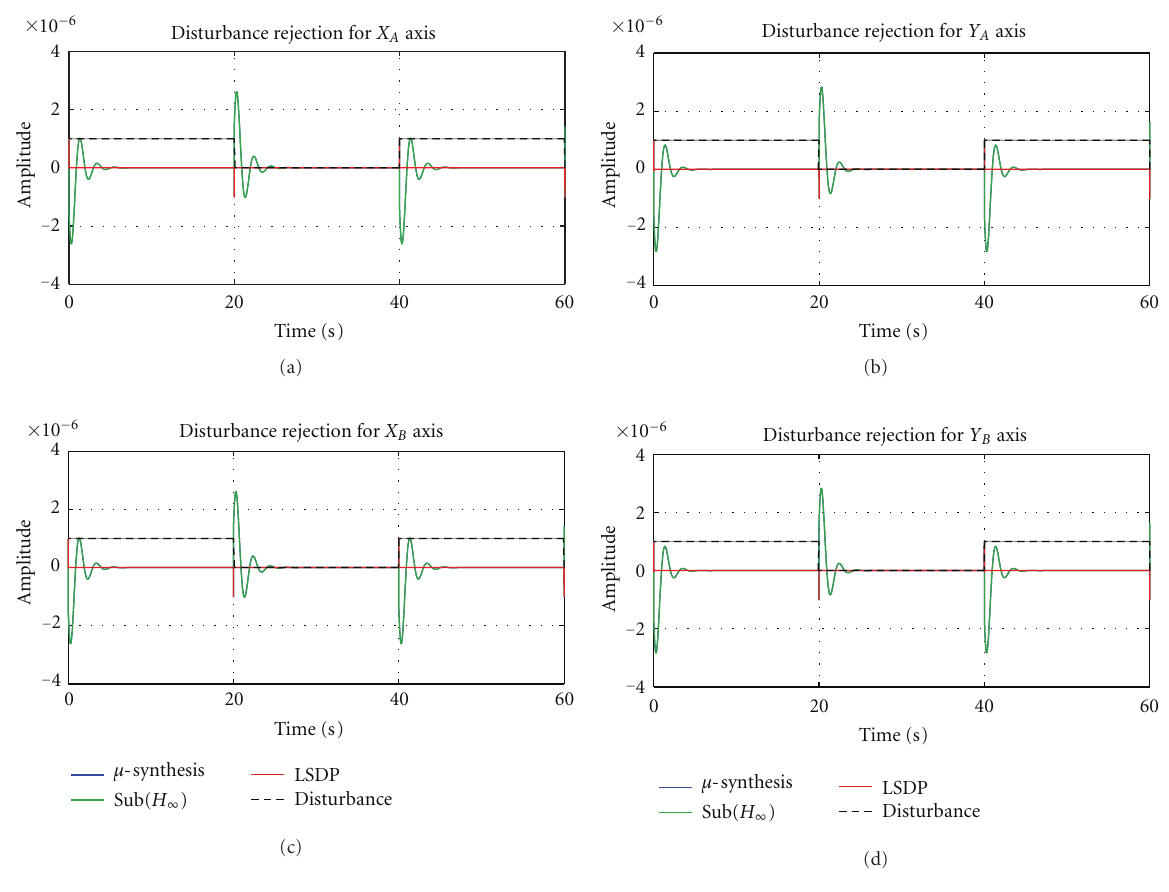
Figure 10: Comparison via simulation for disturbance rejection